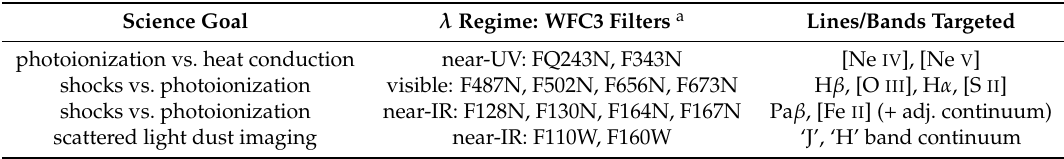
Table 1. Hubble Space Telescope (HST)/Wide Field Camera 3 (WFC3) Imaging Survey of NGC 7027 and NGC 6302: